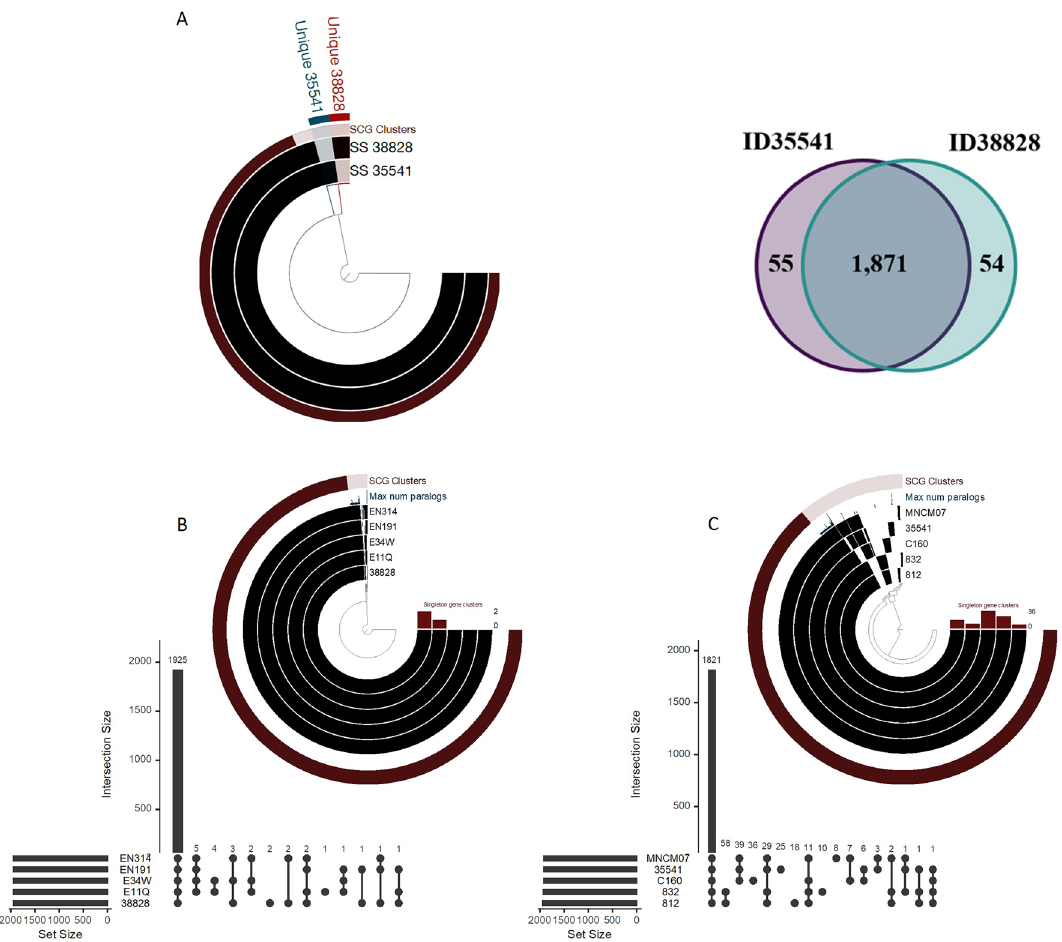
Figure 4. Pangenome analysis representation based on anvi’o software. (A) Pangenome reconstructed with two complete genomes of S. suis strains ID35541 and ID38828. Each ring in the graph represents an individual S. suis genome and each ray corresponds with a given gene homolog. The two inner layers are colored in black to mark gene clusters found in that genome or left with a translucent background if the gene cluster is absent from that genome. The third layer shows density plot of number of paralog genes. The outermost ring illustrates the single-copy genes (SCG; brown color) and accessary genes of strain ID35541 and ID38828 in torque and magenta highlight, respectively. Based on anvi’o pangenome analysis, there are 1871 core genes common between two strains ID38828 and ID35541. The accessory genes of strains ID38828 and ID35541 show 54 and 55 genes, respectively. (B) Pan-genome reconstructed with 5 genomes of S. suis strains ID38828, EN314, EN191, E34W, and E11Q. (C) Pan-genome reconstructed with 5 genomes of S. suis strains ID35541, MNCM07, C160, 832, and 812. Each ring in the graph ( B and C ) represents an individual S. suis genome and each ray corresponds to a given gene homolog. The five inner layers are in black to designate gene clusters in that genome or translucent if the gene cluster is absent. The third layer shows a density plot of number of paralog genes. The outermost ring illustrates the single-copy genes (SCG; brown). UpsetR showing the number of genes that are shared and unique between the